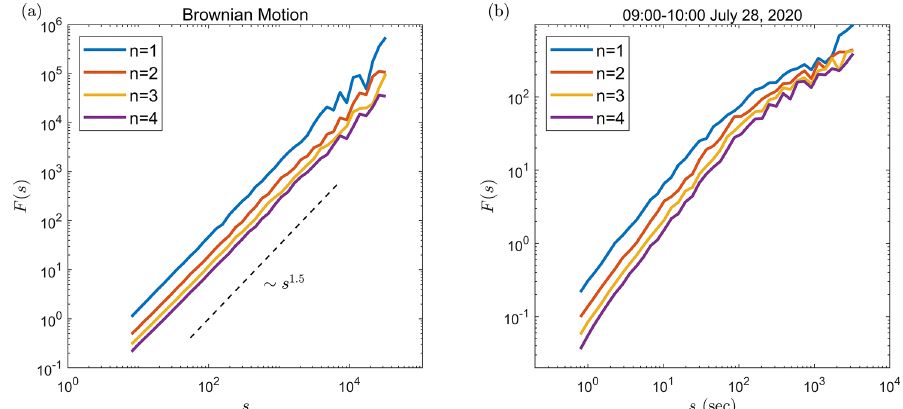
Figure 2. The DFA of (a) the Brownian motion and (b) the 1h time series of carbon dioxide turbulent fluxes with the Reynolds average time of 900s. The results with different degrees n of the polynomial in the DFA are shown by different colour lines clarified in the legend. For the Brownian motion, the standard deviation of g i (see Eq. 2) is set to 1. The broken line indicates the theoretical prediction (Höll and Kantz,